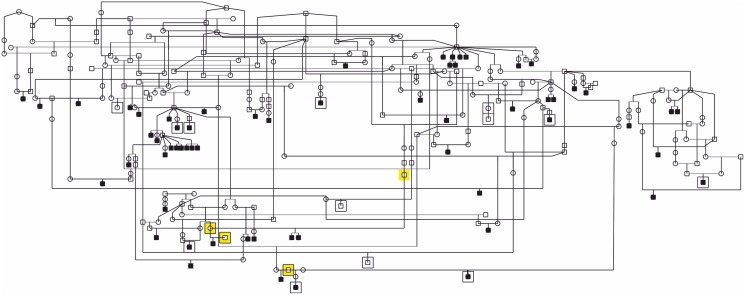
Pedigree of glaucoma affected Norwegian Elkhounds.The pedigree constructed around affected dogs indicates a likely recessive mode of inheritance as the affected dogs are born to unaffected parents and there are multiple affected littermates in some litter. The squared dogs were included in the GWAS. Individuals marked with yellow background were genotyped as obligatory carriers and were all heterozygous for the mutation.